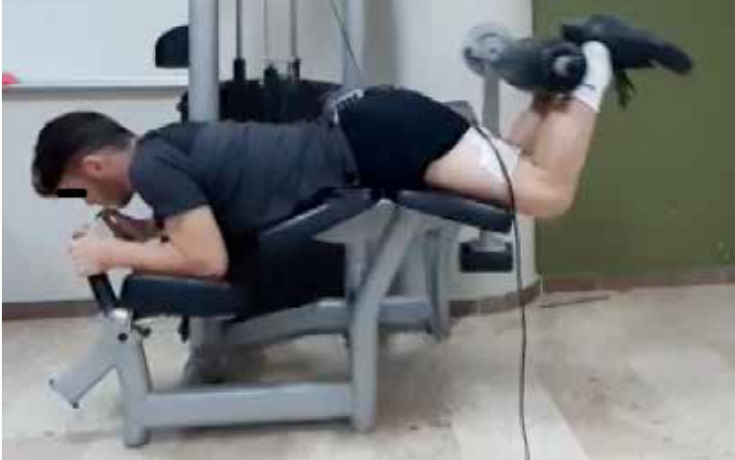
Figure 3. Prone Leg Curl Exercise